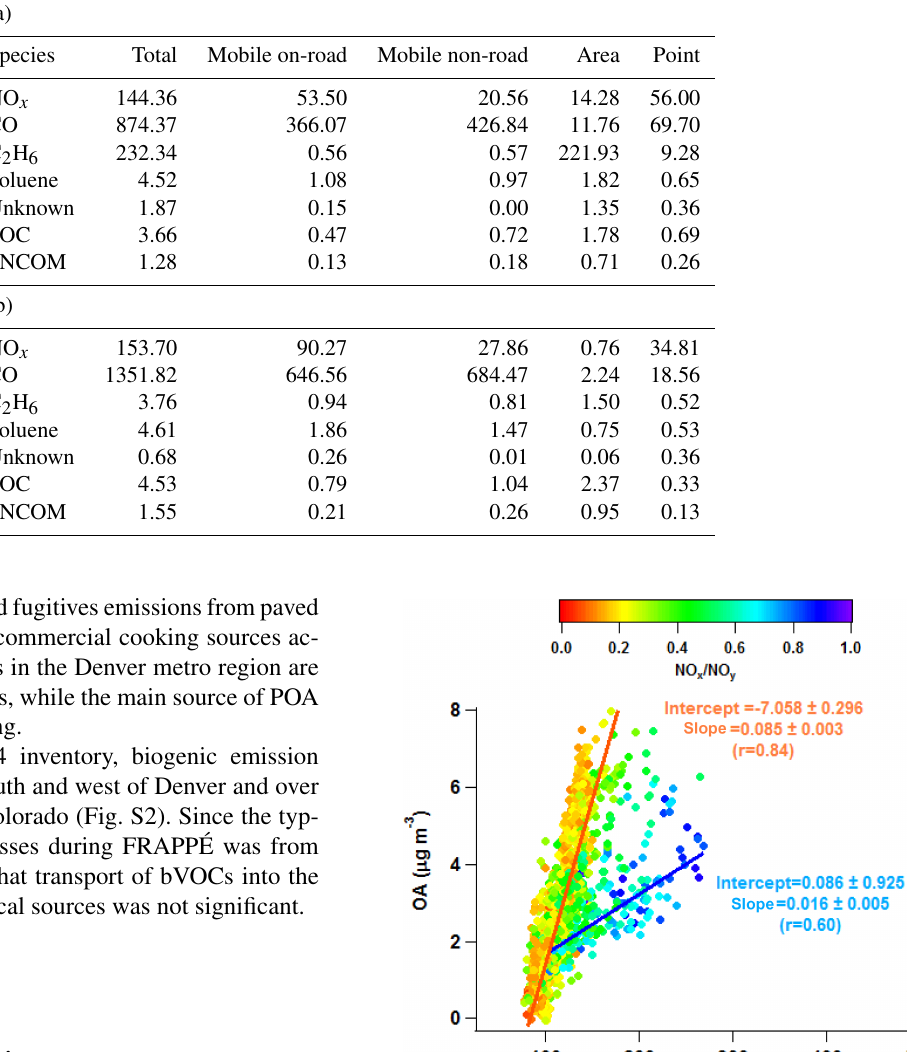
(30 %) and CO (3 %). Uncertainties in the slopes represent 95 % confidence intervals. Almost a factor of 5.5 increase in (cid:49) OA/ (cid:49) CO indicates a significant production of SOA